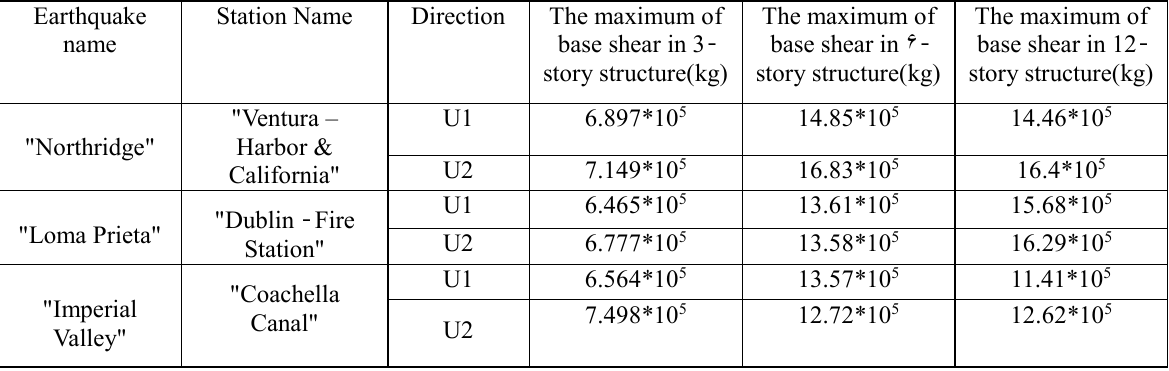
The maximum of base shear in 3, 6 and 12-story buildings. Earthquake